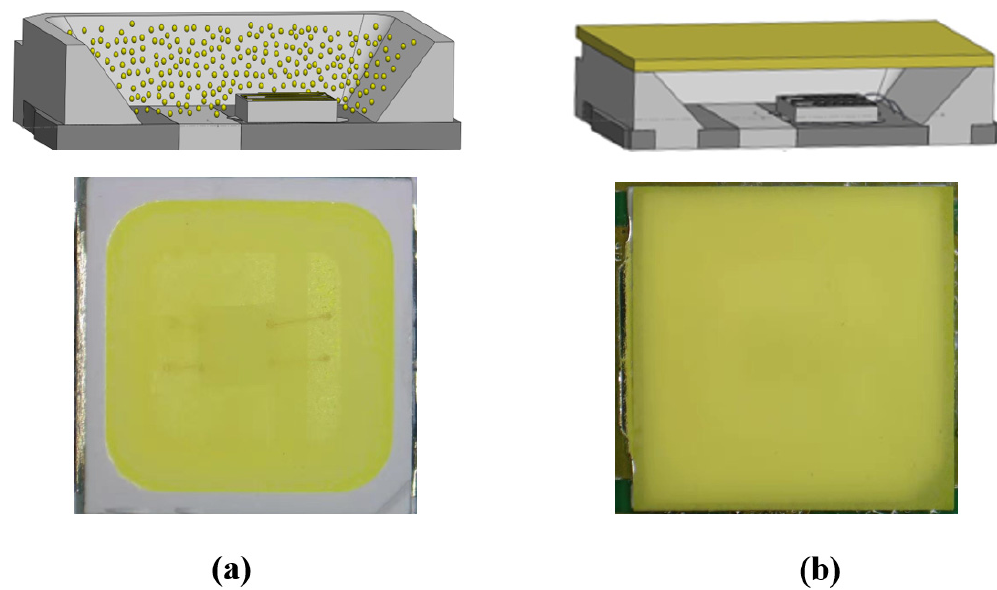
Figure 1. Schematic and top view of ( a ) phosphor in silicone white-light-emitting diode (PiS WLED) and ( b ) phosphor in glass (PiG) WLED.